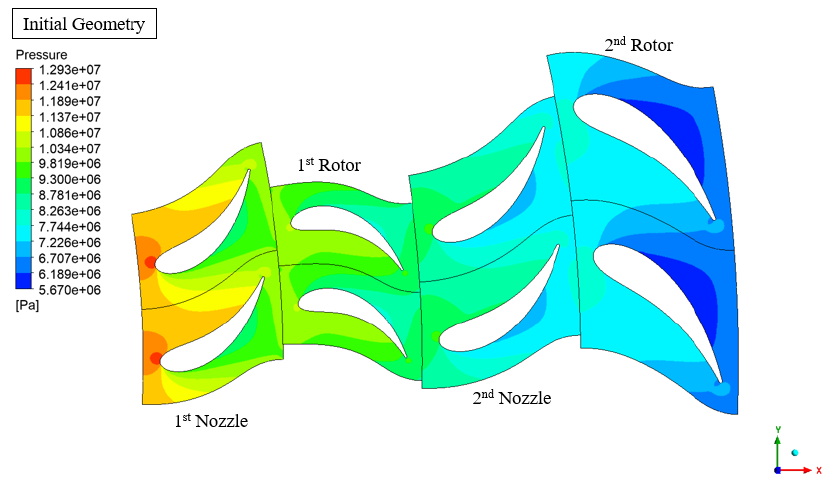
Figure 19. Pressure contour of the initial geometry.